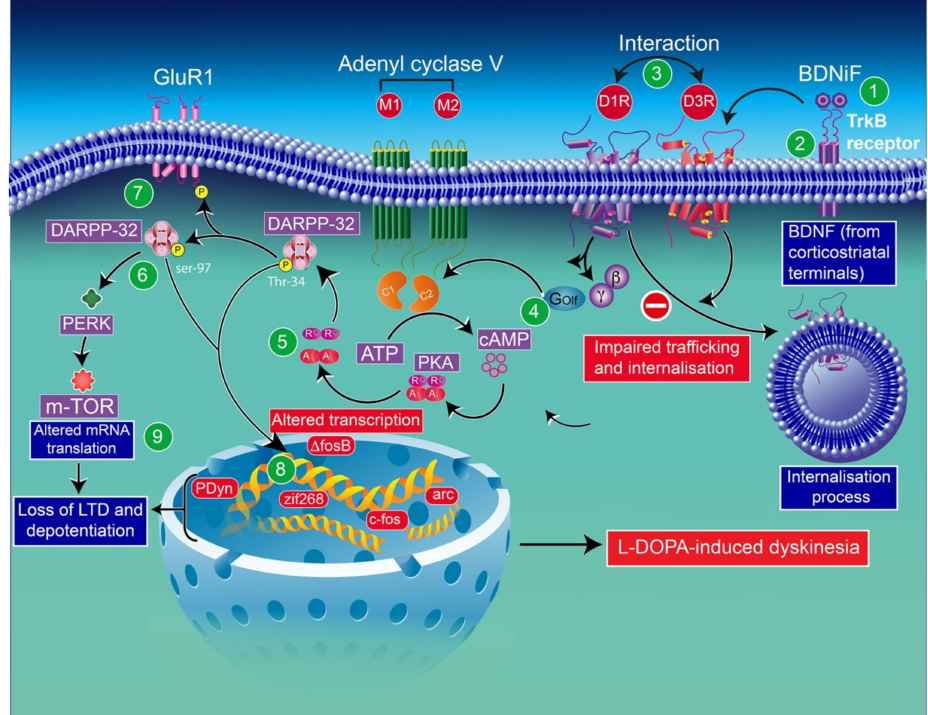
Figure 3. Schematic representation of D3R and D1R interaction through some abnormalities in DAergic signaling caused by sensitized D1R signaling in the context of LID: D3R overexpression in the D1-enriched direct GABA pathway may contribute to the sensitization of D1Rs and the development of LID [70]. The enhancement of BDNF release (1) by chronic treatment with L -DOPA elicits the activation of Tr κ B (2) receptors and induces the overexpression of D3Rs. The levels of membrane-bound D1Rs increase through direct interaction with D3Rs (3). Thus, exacerbated D1R sensitization has been associated with dyskinetic behavior. D1R-induced increased levels of adenylyl cyclase (mostly the AC5 isoform) (4) through the stimulatory heterotrimeric Golf α subunit results in the production of cAMP, leading to hyperactivation of PKA (5) and DARPP-32 (6). Either pharmacological inhibition of PKA or genetic inactivation of DARPP-32 appears to reduce LID. Thus, abnormalities in PKA/DARPP-32 signaling seem to increase the phosphorylation of the GluR1 subunit of the AMPA receptor (7). The subsequent increase in striatonigral MSN excitability through D1 receptors may be involved in the loss of the expression of corticostriatal long-term depression (LTD) and long-term potentiation (LTP) (8). The activation of ERK through sensitized D1R mediates transcriptional processes. The inhibition of ERK signaling was found to counterbalance the induction of LID. CREB phosphorylation, in response to PKA/DARPP-32 and ERK/MSK1 signaling, im- proves the expression of immediate early genes ( ∆ fosB) and prodynorphin (8). ERK activation may improve mTORC1 complex-dependent signaling, thereby initiating mRNA translation and protein synthesis (8). mTOR-mammalian target of rapamycin; DARRP-32-dopamine- and cAMP-regulated phosphoprotein of 32 kilodaltons; PERK-RNA-dependent protein kinase (PKR)-like ER kinase; BDNF- brain-derived neurotrophic factor; PKA-protein kinase A; cAMP-cyclic adenosine monophosphate; PDyn-prodynorphin; Zif268-zinc finger family